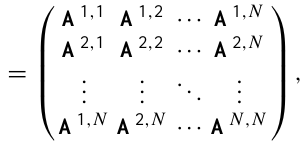
cated by the green and black squares. The diagonal block (green square) represents the covariance within a measure- ment time, whereas the off-diagonal block (black